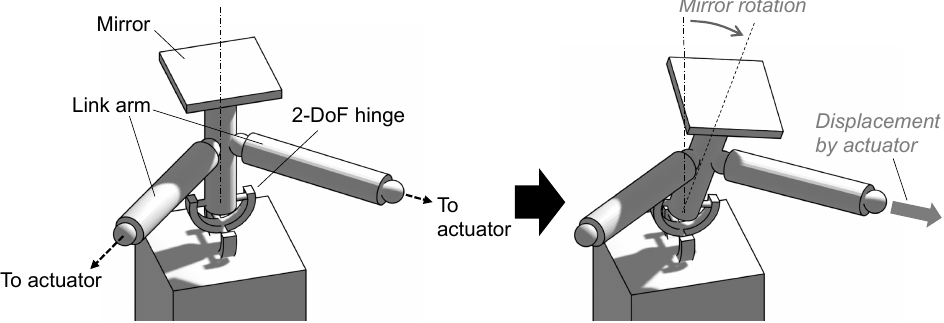
Figure 1. Concept of 2-DoF translation-rotation conversion mechanism.